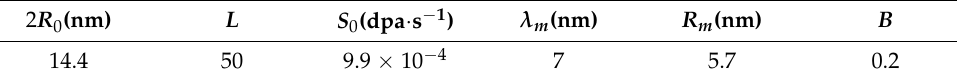
Table 5. Parameters of the modified Frost and Russell model fitted to the experimental